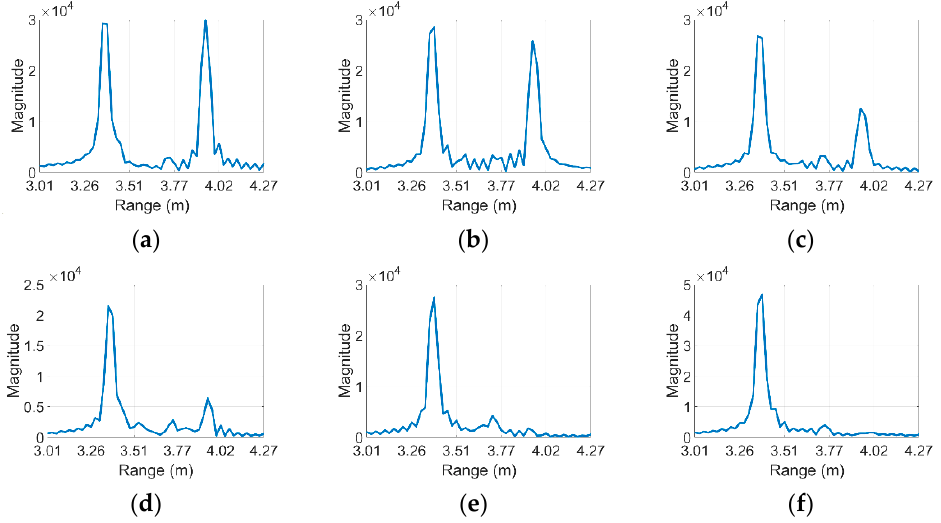
Figure 5. Range-profiles for ( a ) an empty box, ( b ) stage 1, ( c ) stage 2, ( d ) stage 3, ( e ) stage 4, and ( f ) stage